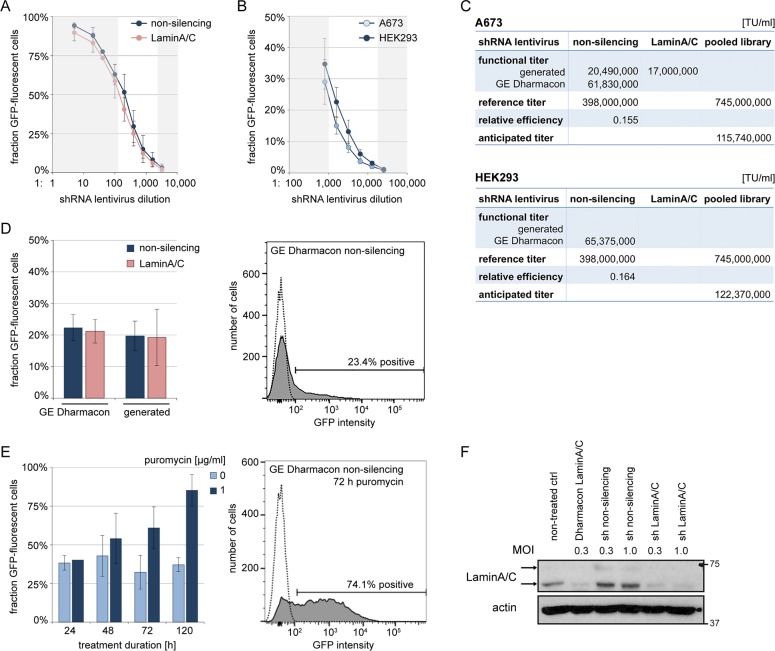
Lentivirus titration and MOI-directed shRNA transduction.(A) Titration curves of non-silencing and LaminA/C shRNA viruses. A673 cells were transduced with serial dilutions of generated lentivirus and GFP expression was analyzed after 72 h by flow cytometry. Functional titers were calculated based on non-shaded dilutions. (B) Titration curves of purchased non-silencing shRNA particles, generated as in (A). (C) Overview of determined functional virus titers [TU / ml] and deduced values. (D) Transduced cell fractions generated with a calculated MOI of 0.3. Left panel: A673 cells were transduced with indicated lentiviruses and GFP expression was analyzed after 72 h. Right panel: Representative flow cytometry plot; shaded graph: transduced cell population; open graph: non-treated control cells. (E) Time-course of puromycin selection. A673 cells transduced with purchased non-silencing shRNA particles in (D) were exposed to puromycin 72 h after transduction. Left panel: GFP-positive cell fractions were determined at time points indicated. Right panel: Representative flow cytometry plot corresponding to that in (D) after 72 h puromycin selection. (F) Western blot of LaminA/C protein expression. A673 cells were transduced as indicated and selected with 1 μg / ml puromycin after 72 h for additional 72 h. Arrows indicate 74 and 65 kDa double-band of LaminA/C. Actin was loading control. All graphs of this figure represent mean ±SD of three independent experiments.